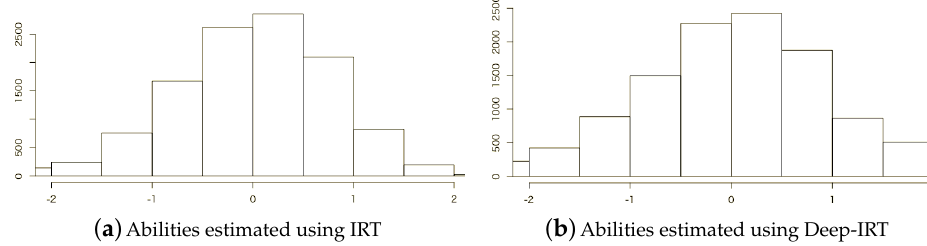
Figure 4. Histograms of abilities estimated using IRT and Deep-IRT for Practice_Math